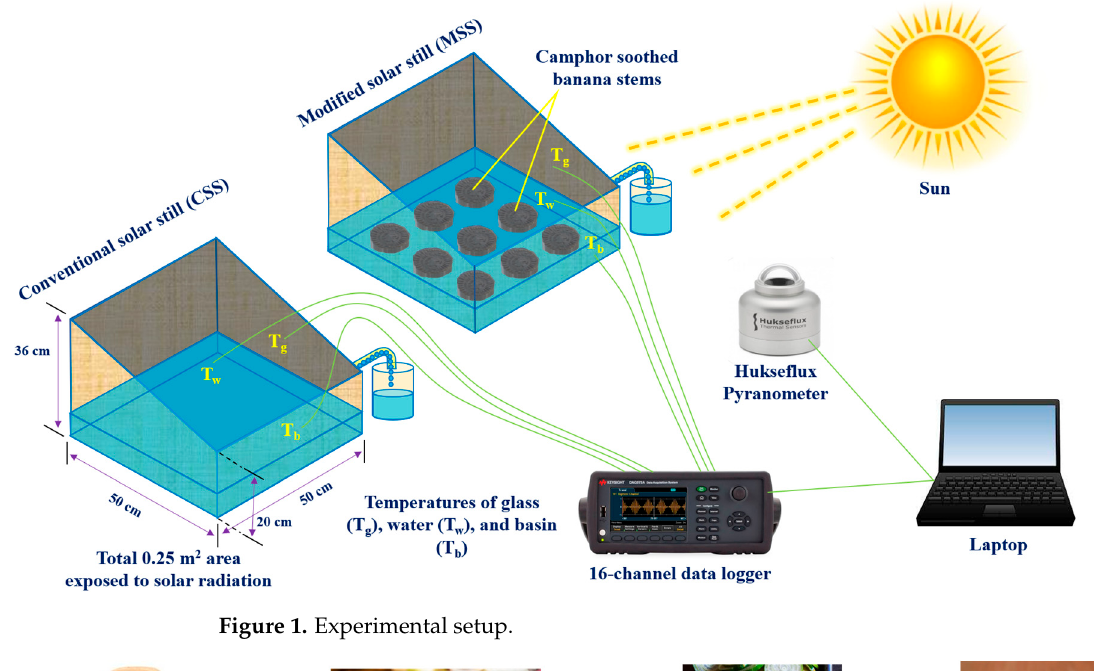
Figure 1. Experimental setup.